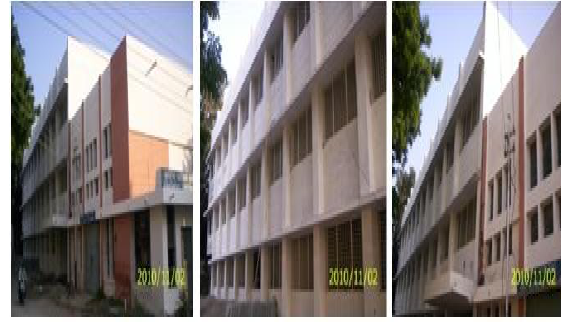
Figure 5. Showing photographs for single-image project (for Photomodeler